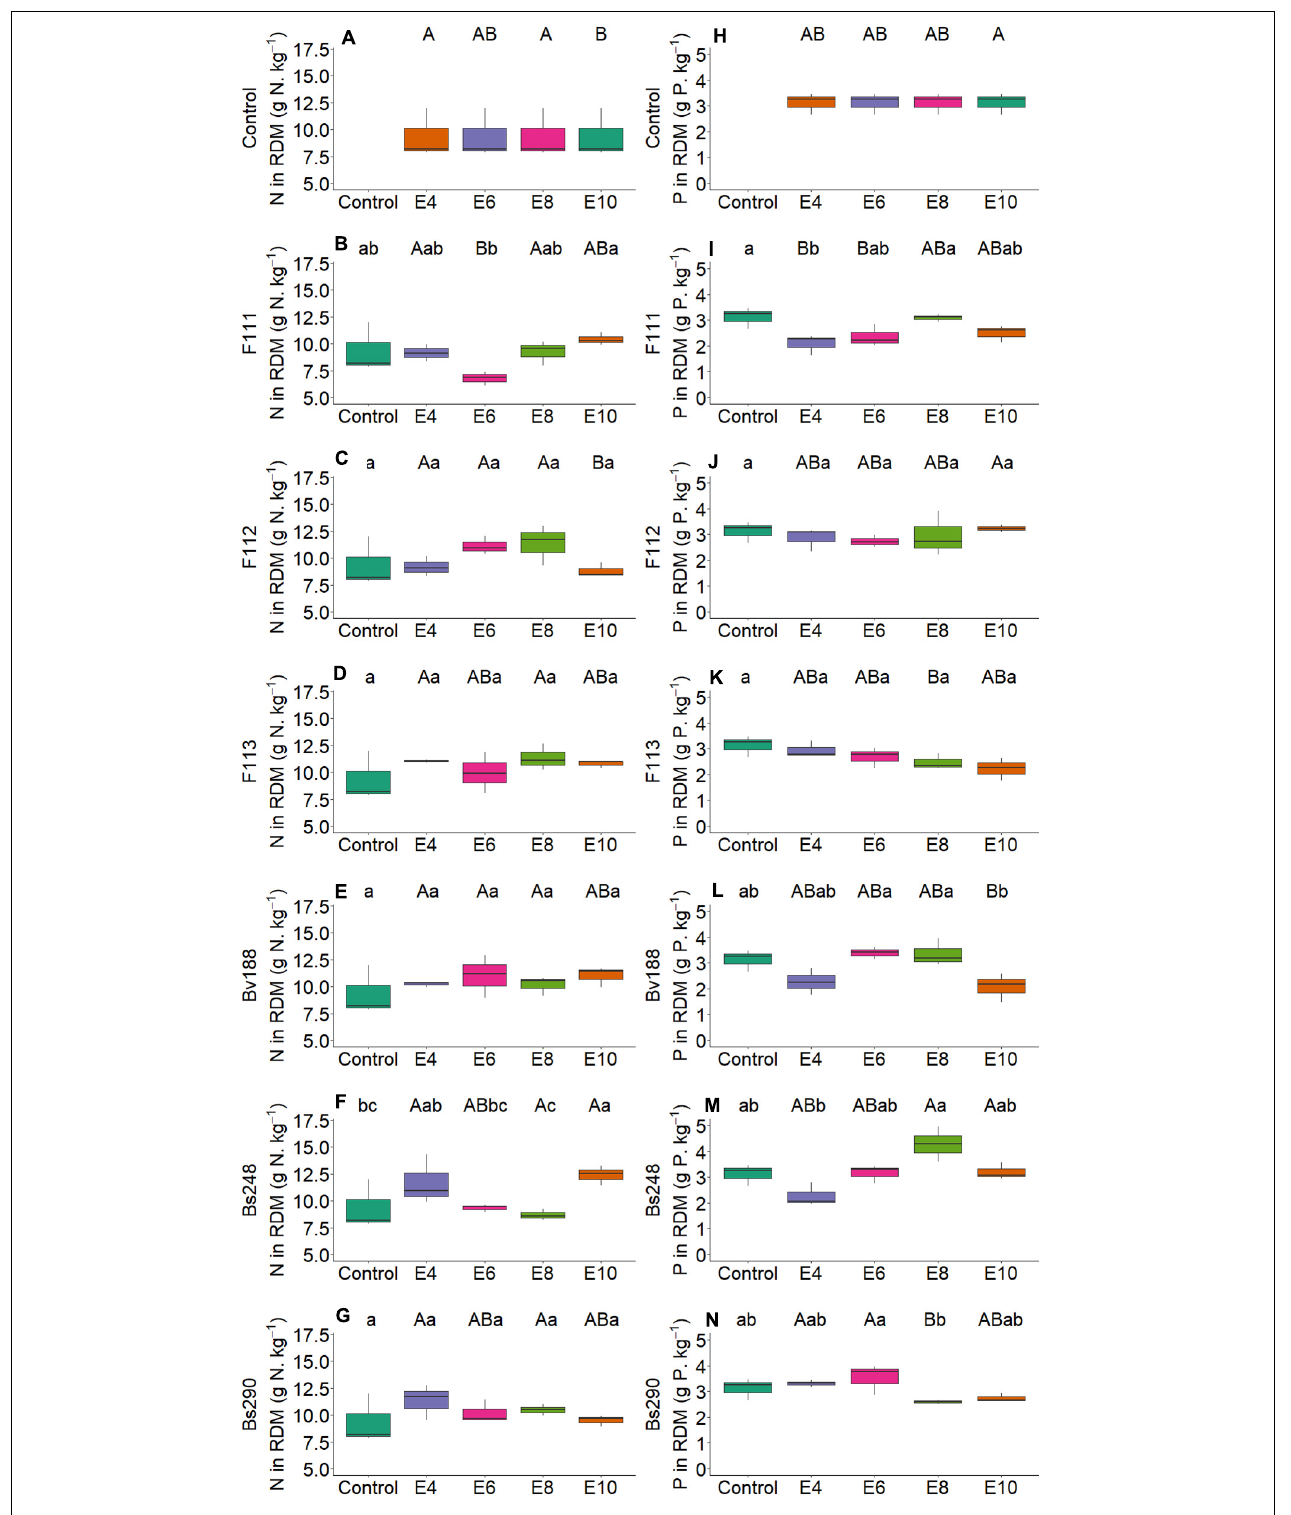
FIGURE 3 | Boxplots (median and quartiles) of nitrogen (A–G) and phosphorus (H–N) content in RDM in cotton inoculated with plant growth-promoting microorganisms. Different lowercase letters in a row and uppercase letters in a column indicate statistical difference between means (Tukey, p < 0.05). F111, Aspergillus brasiliensis ; F112, Aspergillus sydowii ; F113, Aspergillus sp.; Bv188, Bacillus velezensis strain Bv188; Bs248, Bacillus subtilis strain Bs248; Bs290, B. subtilis strain Bs290; E4, 1 × 10 4 ; E6, 1 × 10 6 ; E8, 1 × 10 8 ; E10, 1 × 10 10 conidia or CFU mL − 1 ; Ctrl, control; RDM, root dry matter; CFU, colony-forming units.